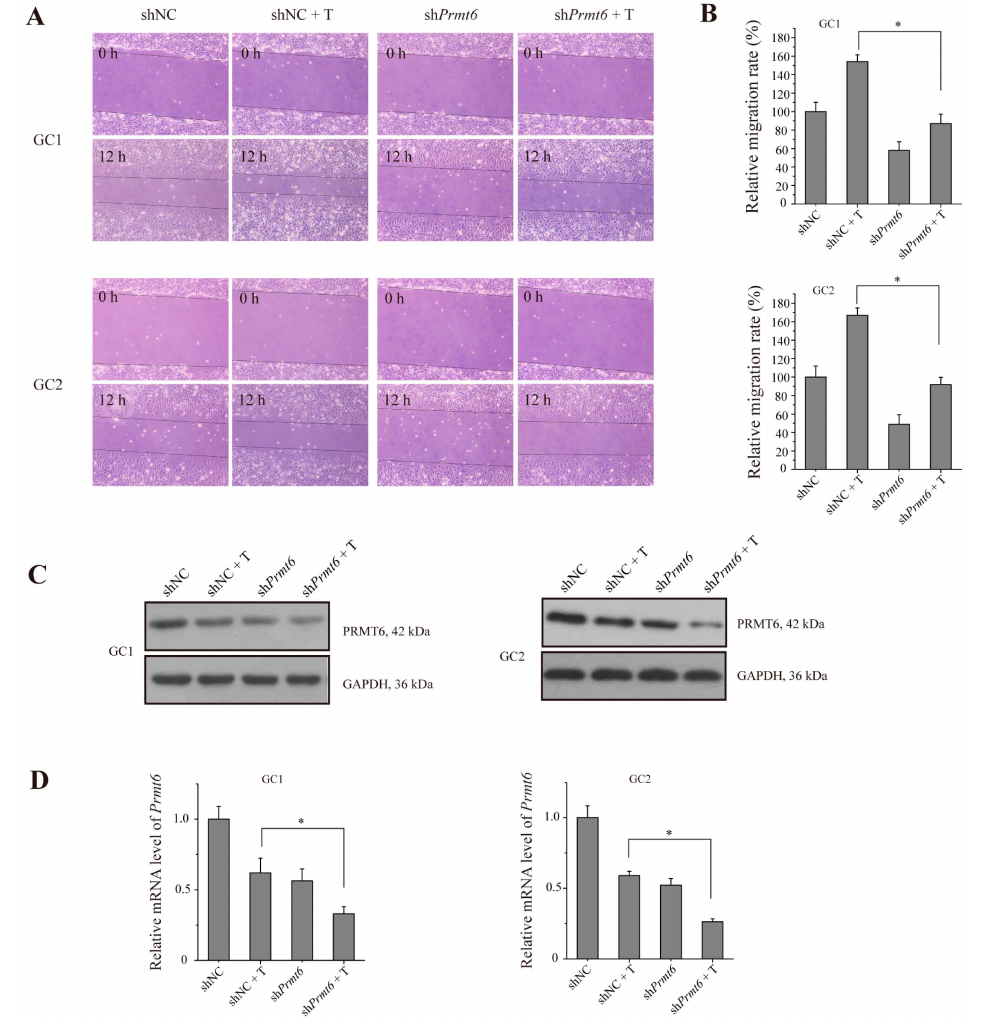
Figure 6. The migratory ability of germ cells is repressed by blocking the function of PRMT6 together with testosterone (T) treatment. Cells were transfected with shNC or sh Prmt6 together with or without 10 nM testosterone treatment. ( A ) Representative photographs of migration assay in GC-1 and GC-2 cells on 0 h (represented the time when the scratch was made) and 12 h are shown; ( B ) Statistical analysis of the relative migratory ability of GC-1 and GC-2 cells; ( C , D ) The expression of PRMT6 protein and Prmt6 mRNA in GC-1 and GC-2 cells were examined by western blotting and RT-qPCR, respectively. The expression of Gapdh mRNA and GAPDH protein were used as a loading control. All of the experiments were repeated at least three times. Data are expressed as the mean ˘ SD. * p <